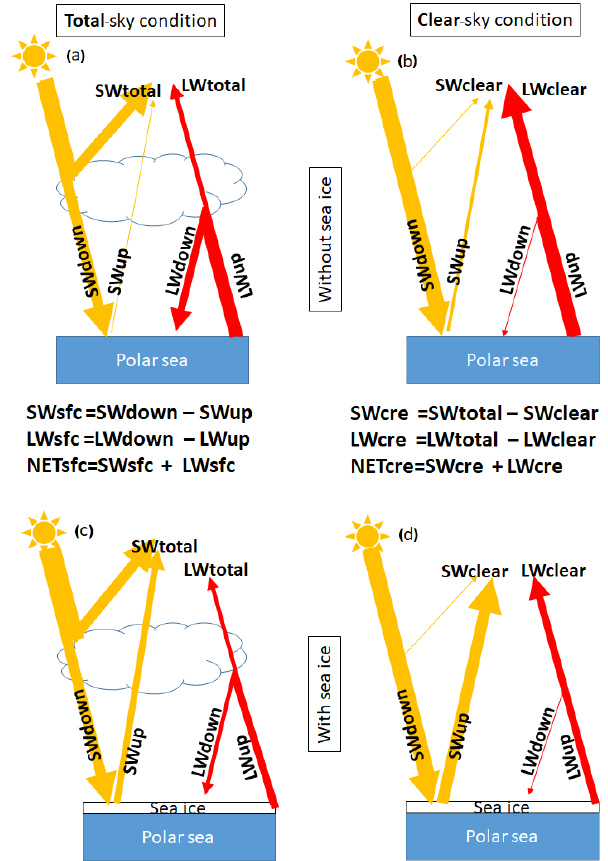
Figure 1. Schematic representation of radiative energy flows in the polar seas under total-sky conditions (a, c) and clear-sky conditions (b, d) for two contrasting surface conditions: without sea ice (a, b) and with sea ice (c, d) . All fluxes are taken positive